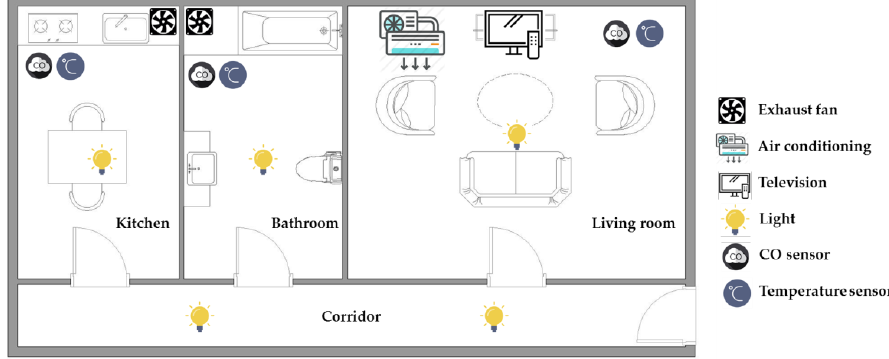
Figure 5. Layout of the smart home with environmental sensor location and placement.